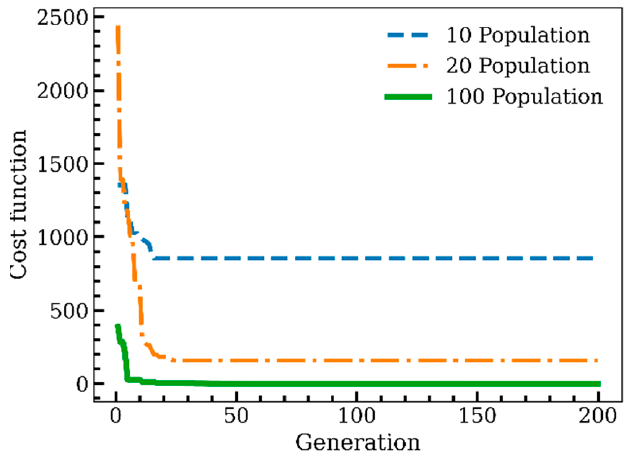
Figure 5. The convergence of the cost function of the optimization problem for different numbers of the initial population.